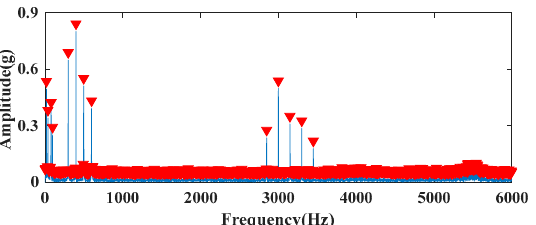
Figure 7. The local maximum values in the frequency spectrum of the original signal. After calculating the envelope of y 0 ( t ), the spherical spline interpolation method is